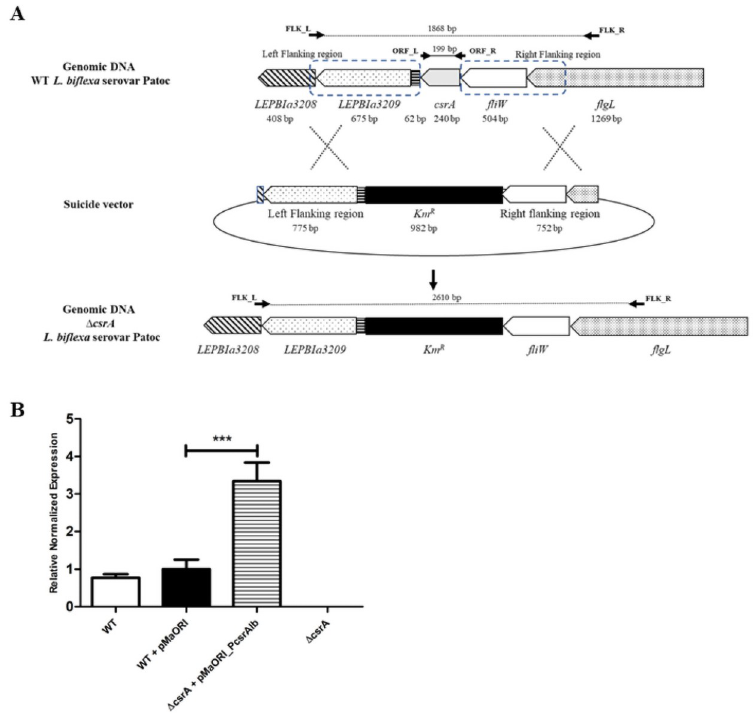
Fig 2. Allelic exchange of csrA in L . biflexa . (A) Schematic representation of homologous recombination. To generate a csrA mutant, L . biflexa serovar Patoc was electroporated with a suicide vector containing the csrA locus where csrA was replaced by a kanamycin resistance cassette ( Km R ). Genes and non-coding regions with their sizes (bp) are indicated. The flanking regions of csrA used for homologous recombination are indicated by the dashed line square. Arrows indicate primers used for the confirmation of double crossing-over events. (B) csrA expression in L . biflexa strains was determined by RT-qPCR. Results obtained from 3 independent cultures were presented as relative fold changes ± SEM using cysK gene for normalization. ( ��� ) indicates p-value <